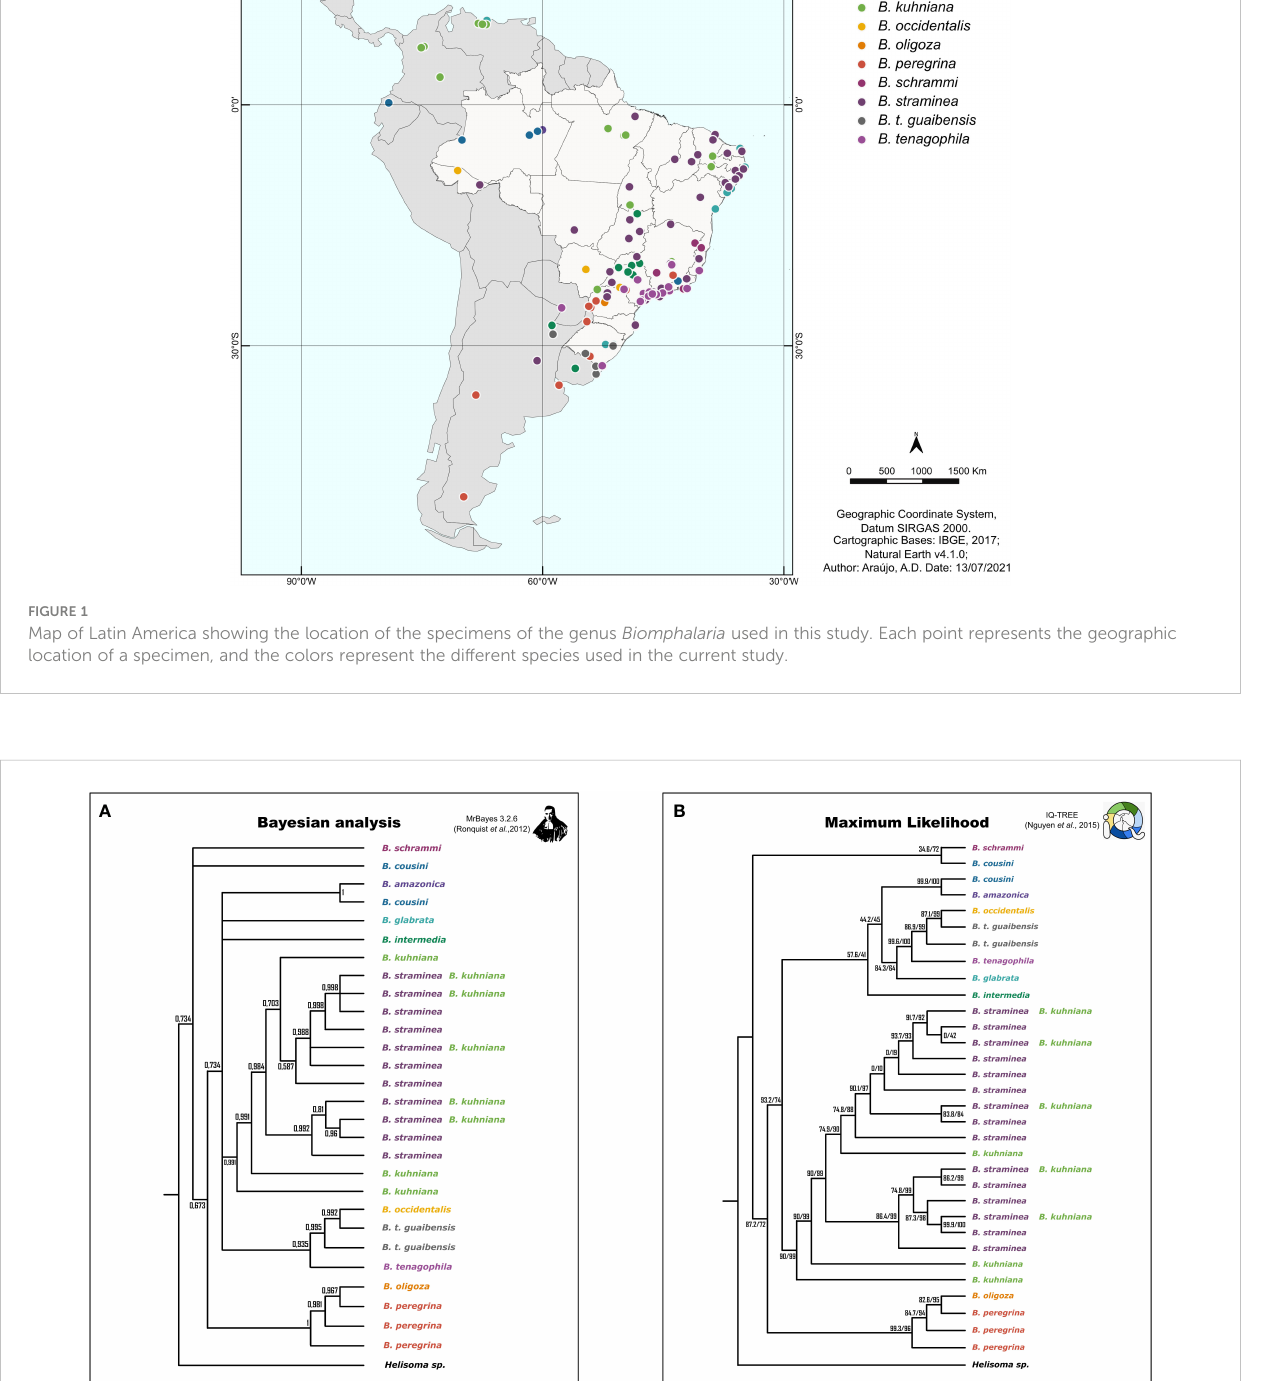
FIGURE 2 Simpli fi ed representation of the phylogenetic trees generated by Bayesian Inference (BI) and Maximum Likelihood (ML) criteria. Species are represented by different colors. Trees generated by MrBayes have posterior probability values represented on the branches (A) . Trees generated by IQ-TREE have two support values for comparison, ultrafast bootstraps (MINH et al., 2013) and the Shimodaira-Hasegawa test (SH-aLRT) (Guindon et al., 2010) (B) .